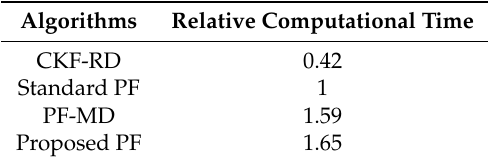
Table 2. Relative computational time for different